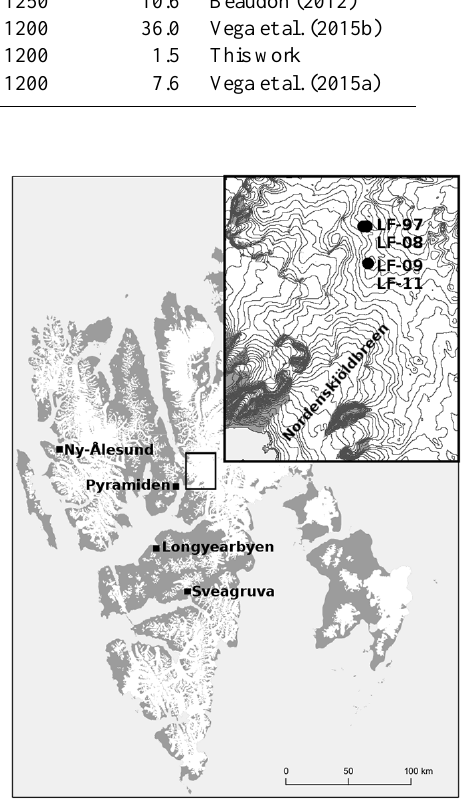
Figure 1. Map of Svalbard showing the main settlements: Longyearbyen, Ny-Ålesund and Pyramiden, and the LF-97, LF-08, LF-09 and LF-11drilling sites at